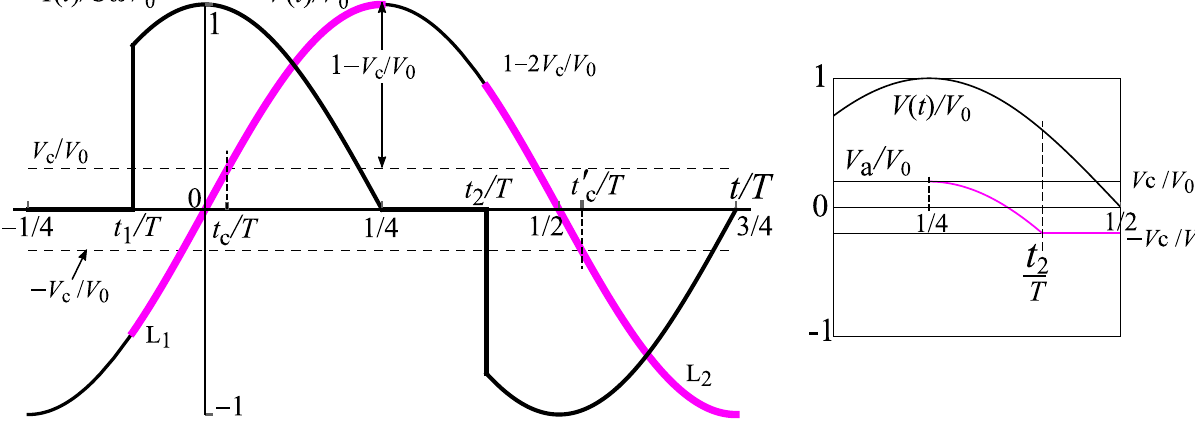
Figure 2. On top of the V ( t )/ V 0 = sin (ω t ) AC supply, the periods of emission of the LEDs L 1 and L 2 are shown (heavy, magenta on-line), starting at times t 1 and t 2 respectively. The times t c and t ′ c are when the supply crosses the threshold, V 0 sin (ω t c ) = ± V c (light horizontal lines at ± V c ) where conduction would start in simple, resistively-coupled, DC-driven LEDs. Here, conduction starts well before then, indeed for this V c < V 0 / 2 , at a t 1 < 0 when the supply is actually in reverse. This example is for V c = 0.2 V 0 , whereupon t 1 = − 0.102 T . For 50 Hz mains, the off time is t 1 − T / 4 = 3.0 ms. The solid black curves are the current normalised by the maximum current passed by the capacitor, I /(ω CV 0 ) . Inset: V ( t )/ V 0 and V a ( t )/ V 0 against time. While L 1 is conducting (until t = T / 4 ), the voltage V a is pinned to V c , that is V a = V c . From t = T / 4 until t 2 , it drops with the supply as V a = V ( t ) − � V and can be seen to reach − V c , in this case well before V ( t ) = 0